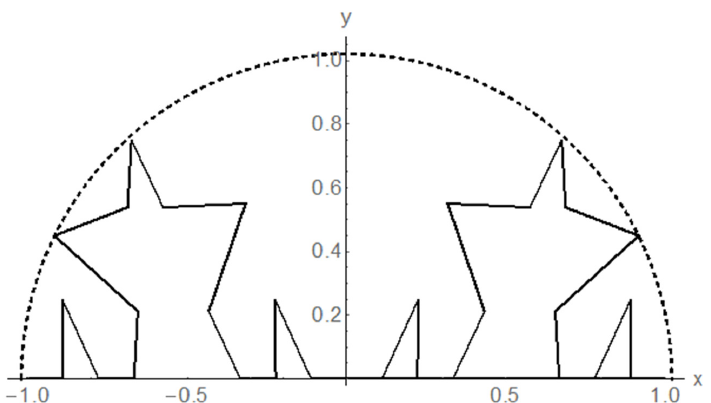
Figure 3. Balanced dipole wire antenna with an arm formed by the Koch-type prefractal of the second iteration.